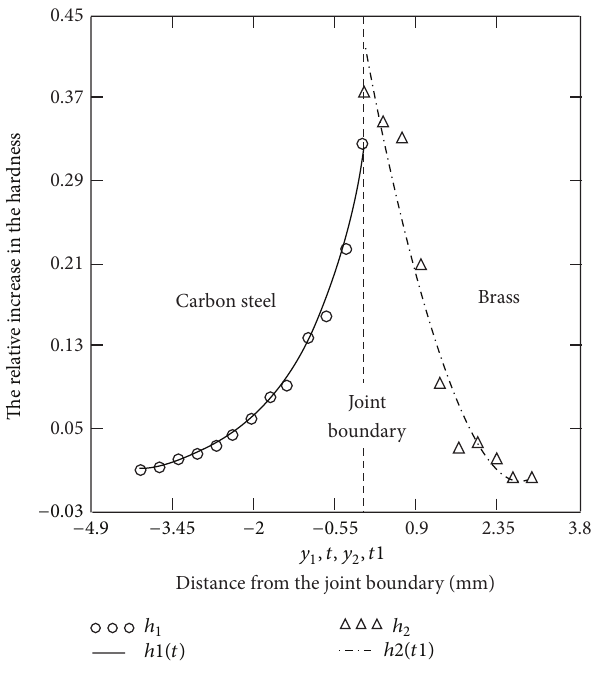
Figure 12: The relative increases ℎ 1 and ℎ 2 of the hardness as a function of distances 𝑦 1 and 𝑦 2 from the joint boundary for the carbon steel-brass joint; ℎ1(𝑡) and ℎ2(𝑡1) are curves smoothed by a loess